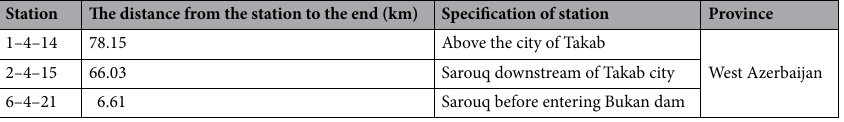
Table 1. Specifications of sampling stations.